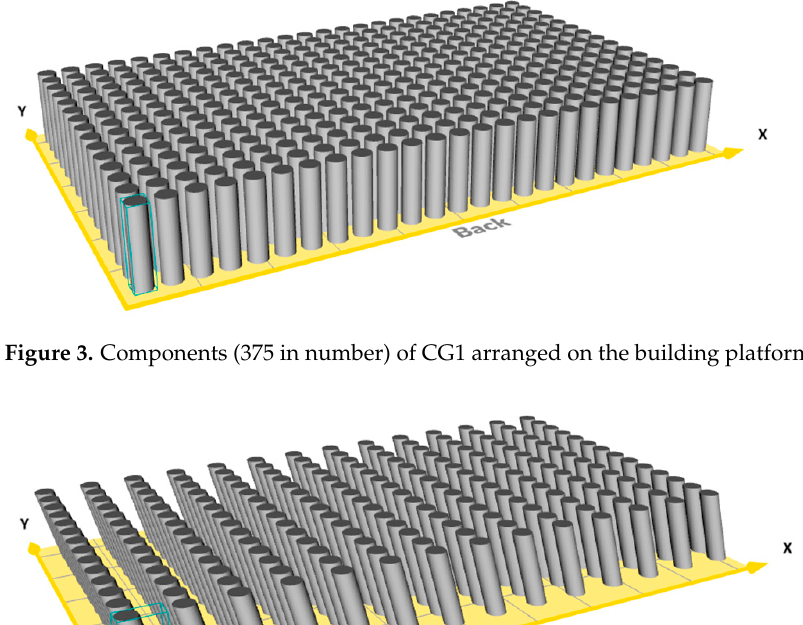
Figure 4. Components (196 in number) of CG2 arranged on the building platform.